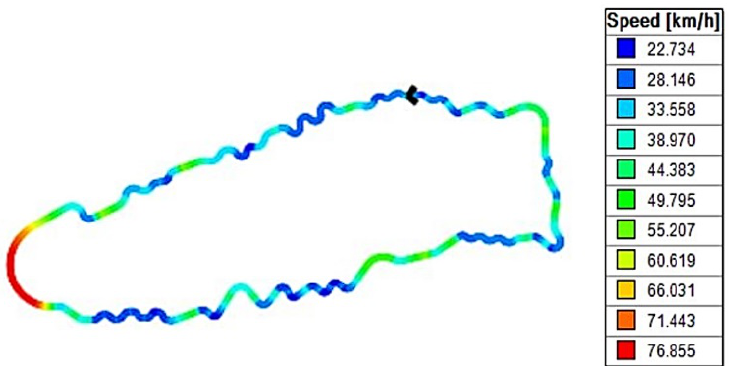
Figure 2. The output of lap-time simulation from optimum lap shows the speed at each instant on the track. Note that due to the lack of long straight lines the top speed of the vehicle is around 77 kmph.